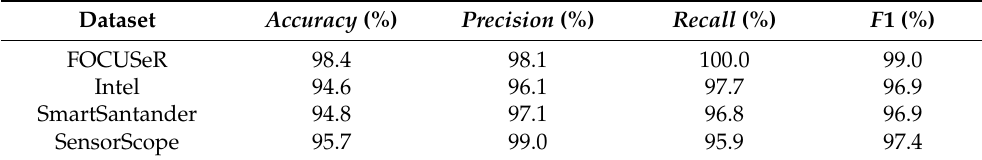
Table 6. Effectiveness of